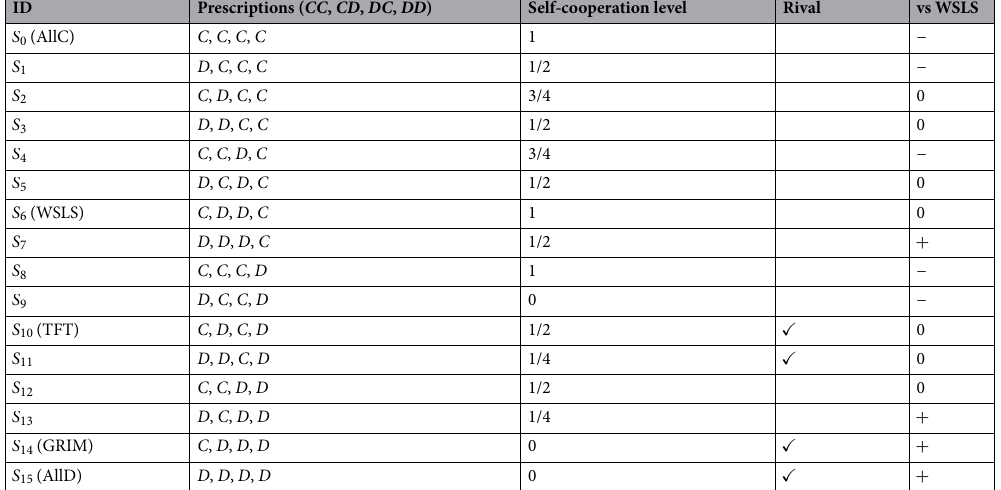
Table 1. Deterministic memory-1 strategies of the repeated prisoner’s dilemma. Memory-1 strategies only depend on the outcome of the previous round. These strategies are deterministic if, given the previous outcome, they either prescribe to cooperate with certainty ( C ), or to defect with certainty ( D ). The four letters in the second column represent which action the strategy prescribes, given the previous actions of the focal player (first letter) and the co-player (second letter). The third column shows the cooperation level when both players use the respective strategy γ p , p (assuming e → 0 ). See “Methods” for details of the calculation. The fourth column indicates whether or not the strategy is a rival strategy. A strategy p is a rival if it enforces the payoff relationship π p , q ≥ π q , p against all co-player’s strategies q . The fifth column shows how each strategy p performs against WSLS (again for e → 0 ). If π( p , WSLS ) > π( WSLS , p ) , then we mark the strategy p with a ‘ + ’. Analogously, if payoffs are equal, we use a ‘0’, and if the payoff is smaller, we use ‘−’. Provided the benefit b > 1 , these relationships are independent of the exact value of b